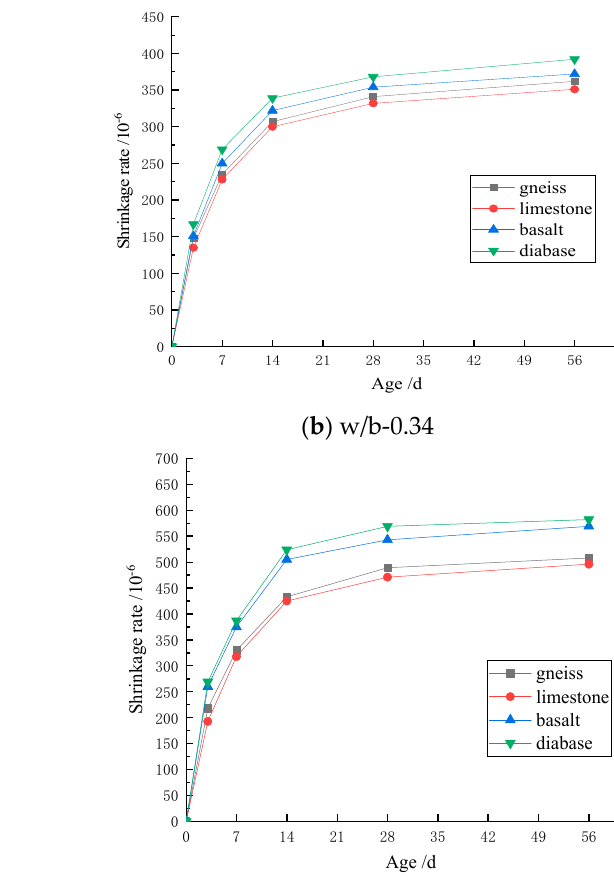
Figure 7. The shrinkage rate of coarse aggregate concrete: ( a ) water-binder ratio of 0.45; ( b ) water-binder ratio of 0.34; ( c ) water-binder ratio of 0.30 and ( d ) water-binder ratio of 0.22.